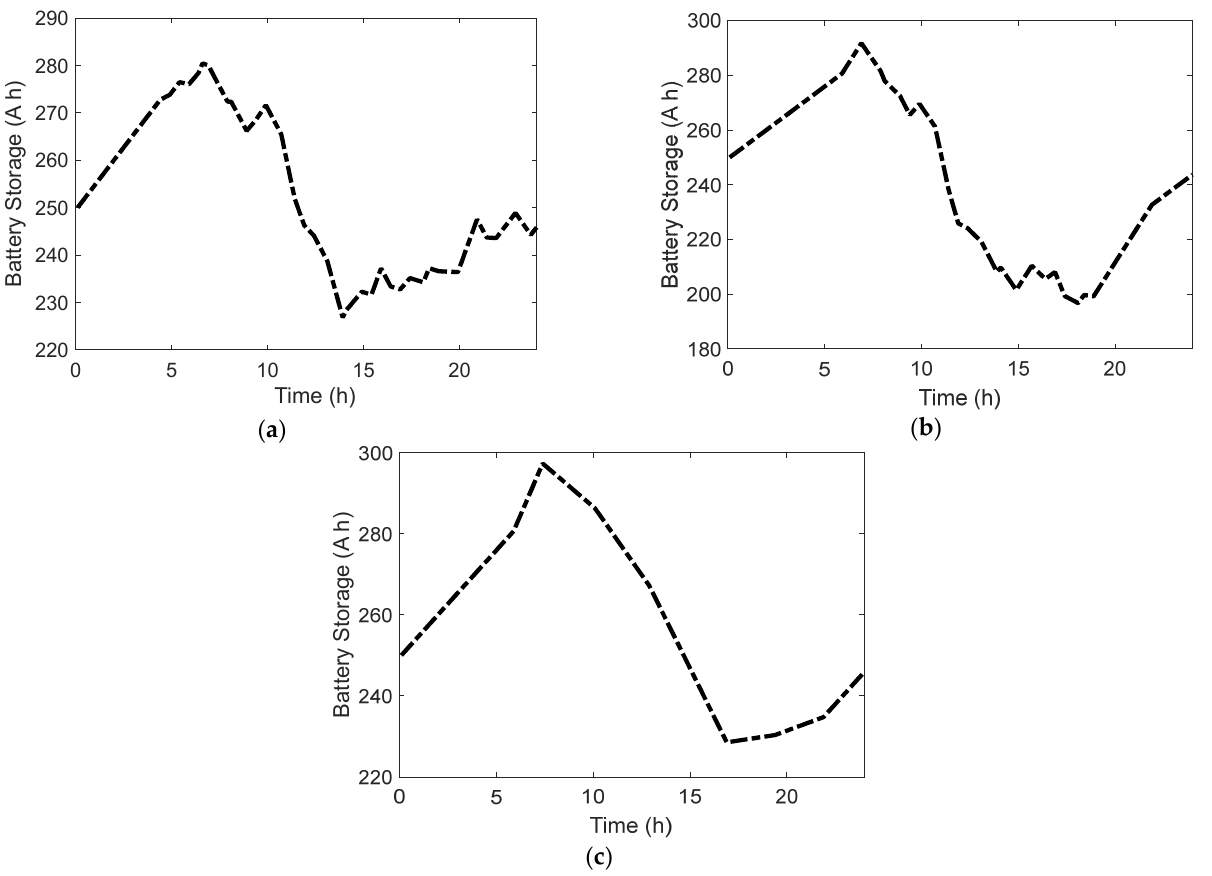
Figure 6. The changes in the storage of battery in different power demand profiles of the proposed system: ( a ) first power load profile, ( b ) second power load profile, ( c ) third power load profile.